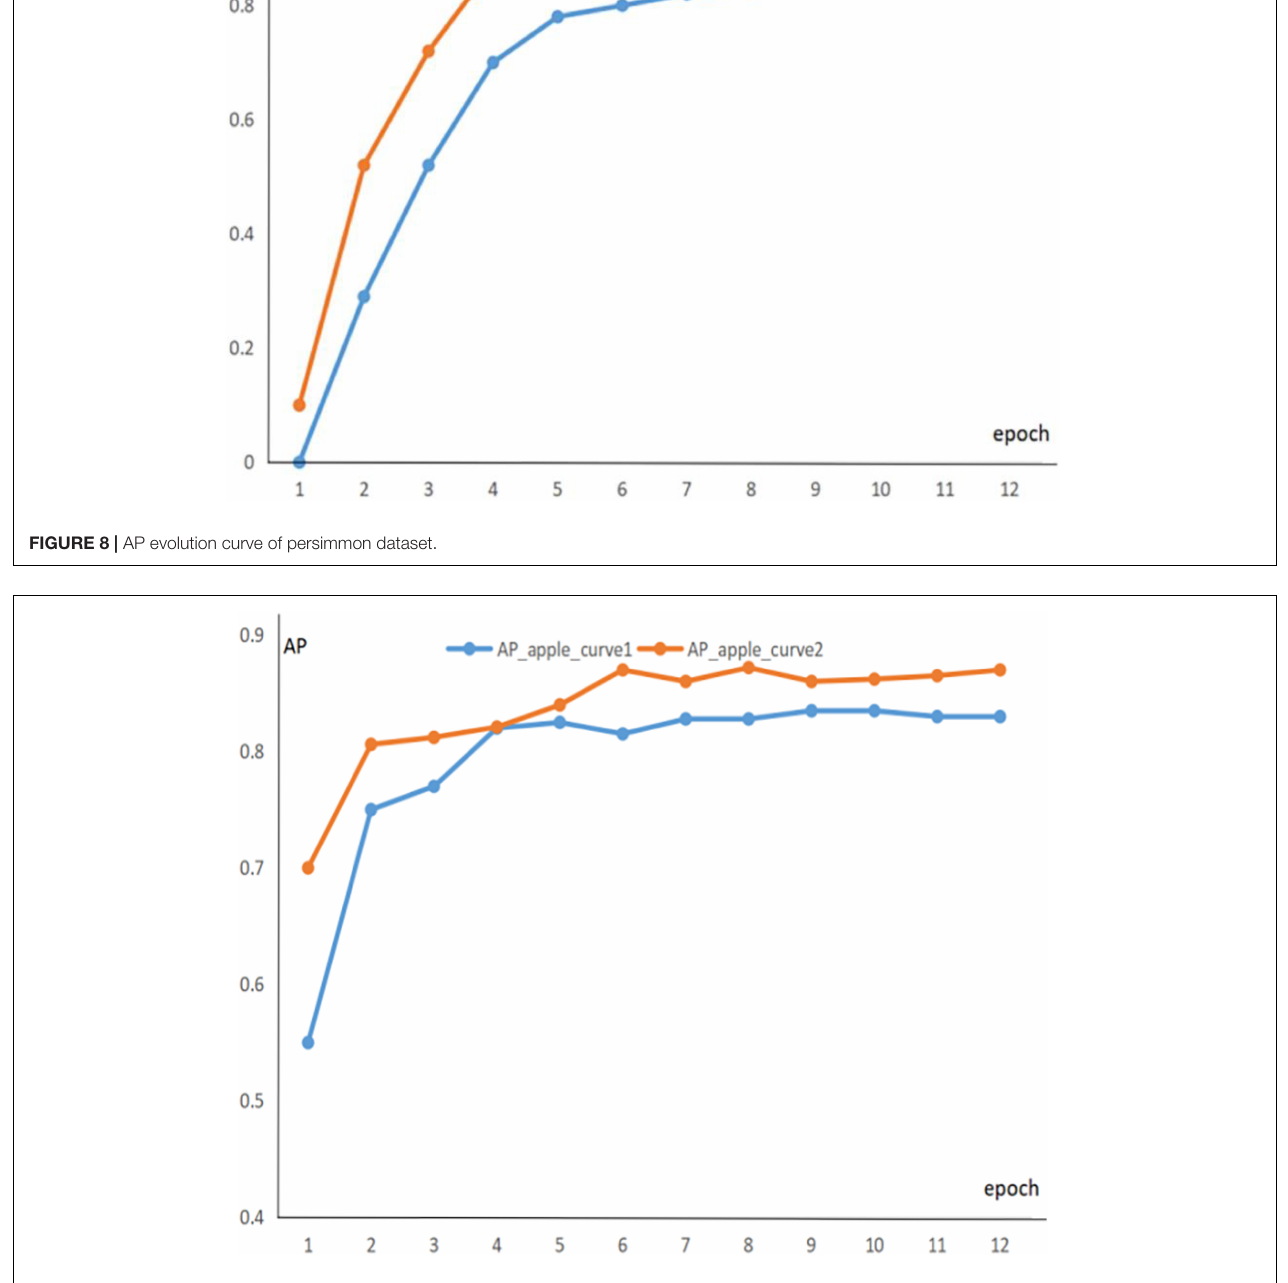
FIGURE 9 | AP evolution curve of apple dataset.